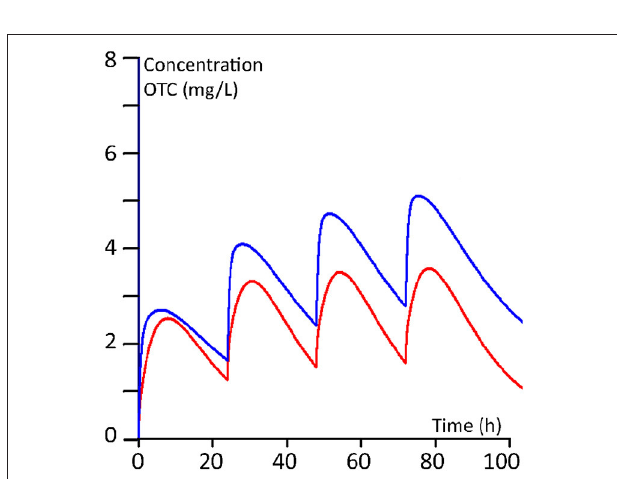
FIGURE 5 | Ten mg/kg regimen (once daily for 4 days). Red line: 100kg BW calves; blue line 400kg BW calves.